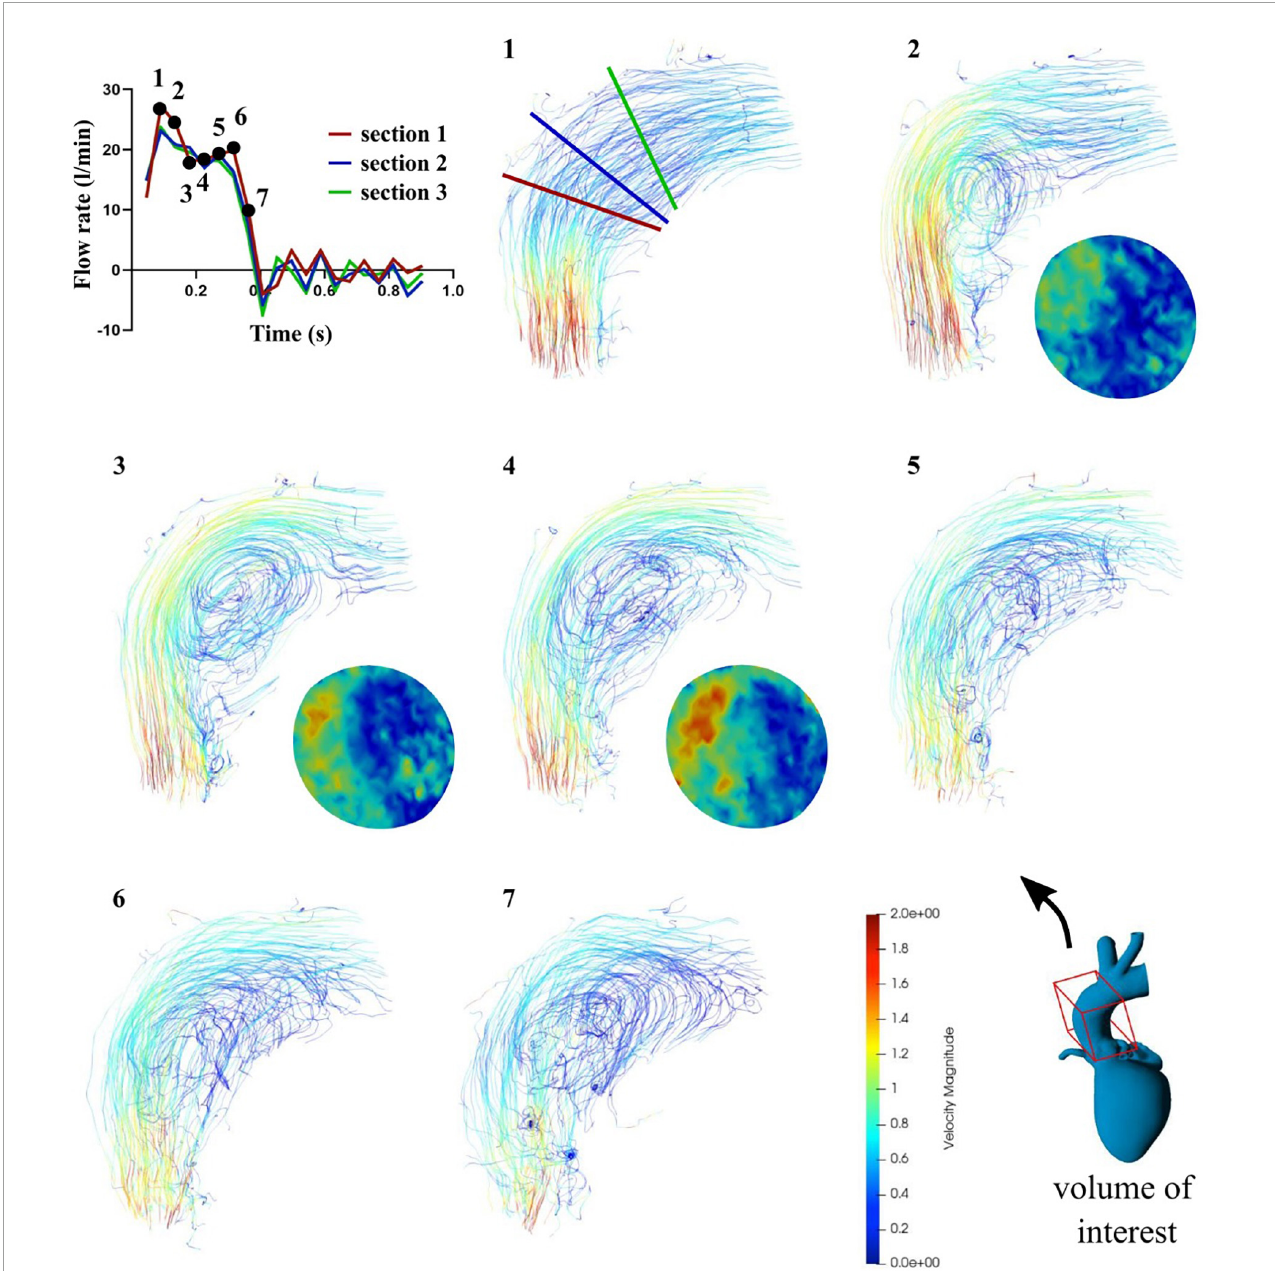
FIGURE7 Flow rates (top left) and streamlines (1–7) in the case of pulsatile flow for seven systolic time frames and contour maps in section 2 for mid systole